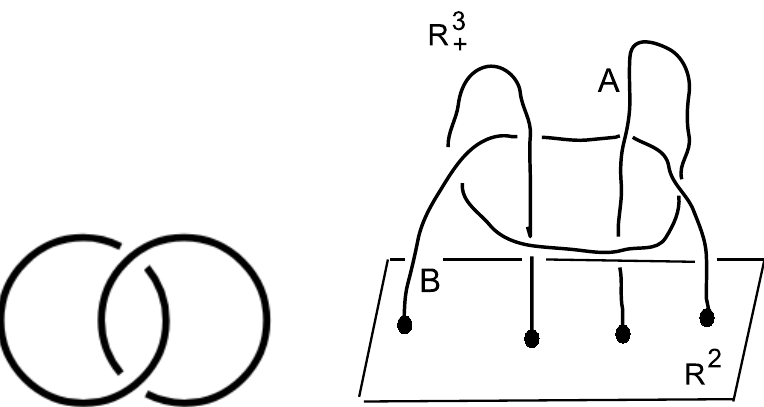
Figure 2. ( Left ): the Hopf link. ( Right ): the link L = A ∪ B is attached to the plane R 2 in the half-space R 3 + . It is not splittable. This can be proved by checking that the fundamental group π = π 2 ( L ) is not free [18] and p. 90 in [19]. One gets π 2 = (cid:104) x , y , z | ( x , ( y , z )) = z (cid:105) , where (.,.) means the group theoretical commutator. The cardinality sequence of cc of subgroups of π 2 is [ 1,3,10,51,164,1365,9422,81594,721305, · · · ] (Figure 3 in [4]).